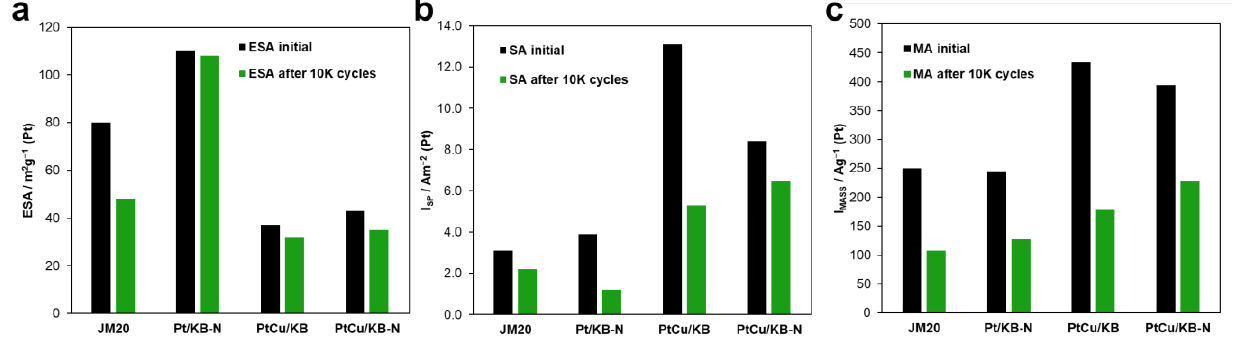
Figure 5. ESA values ( a ), mass activity ( b ), and specific activity ( c ) of the catalysts before and after the stress test.